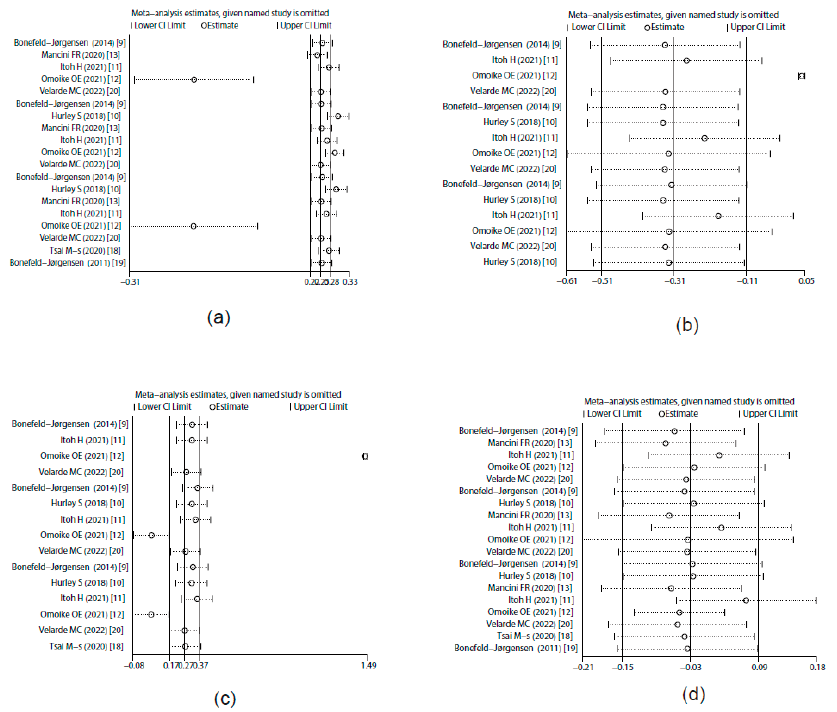
Figure 3. Sensitivity analysis of studies that evaluated the ORs of PFASs. ( a ) PFOA; ( b ) PFNA; ( c ) PFHxS; ( d ) PFOS.